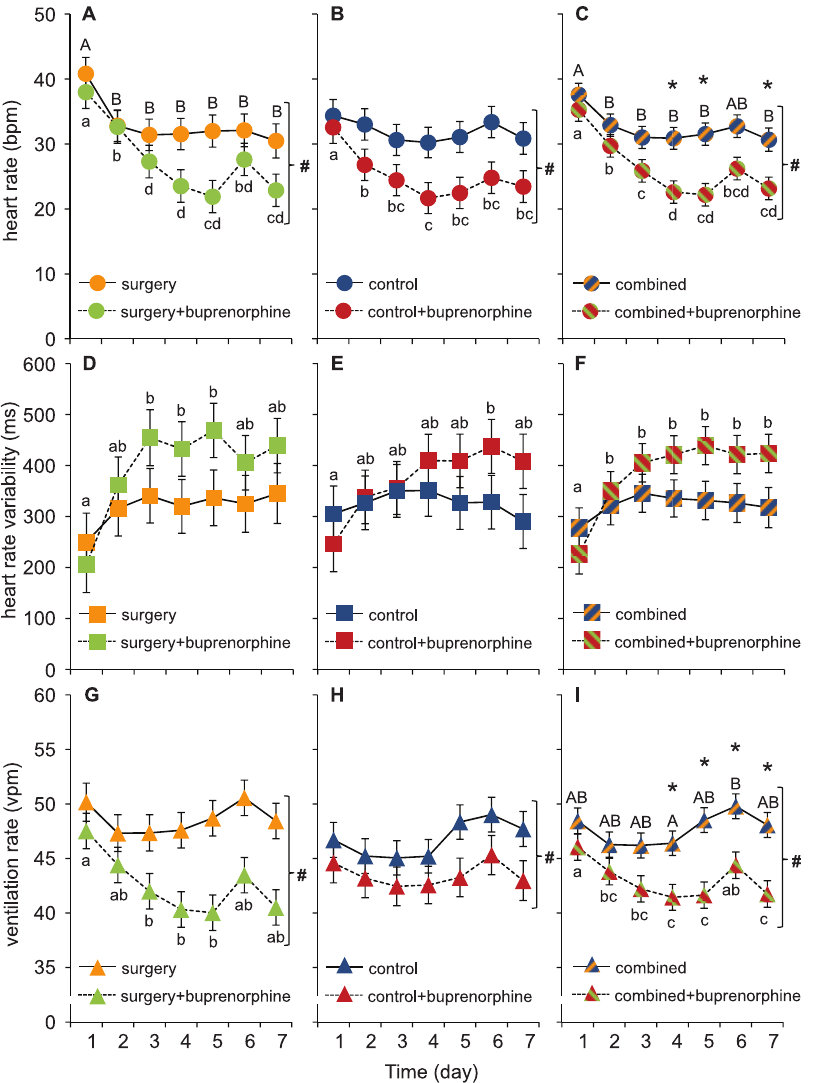
Figure 3. Cardioventilatory variables in rainbow trout ( Oncorhynchus mykiss ) at 10 6 C ( n =9). Data for heart rate (A–C), heart rate variability (D–F) and ventilation rate (G–I) is presented as means 6 S.E.M. Different lower case letters indicate significant differences between days for the fish given an injection of buprenorphine (0.05 mg kg 2 1 ) and different capital letters indicate significant differences between days for the fish not given an injection of buprenorphine. # indicates a general significant effect of the drug across all 7 days and * indicates a significant difference between the groups at a specific day.